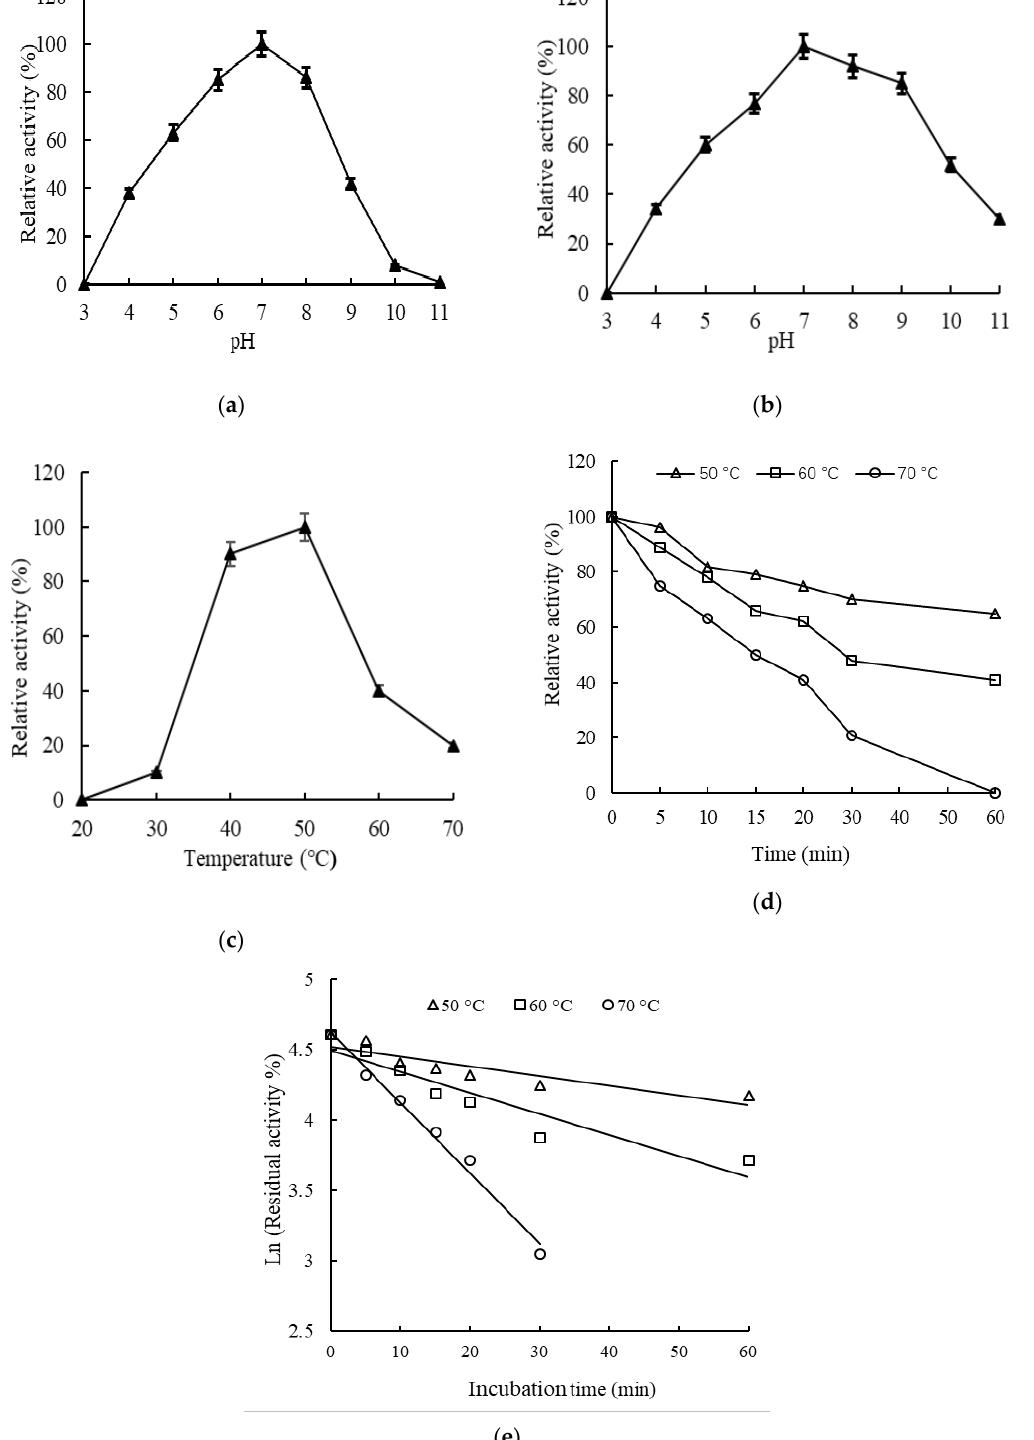
Figure 3. ( a ) Optimal pH of rAga-ms-R. ( b ) pH stability of the rAga-ms-R. T. ( c ) Optimal temperature of recombinant agarases. ( d ) Temperature stability of the rAga-ms-R. ( e ) Thermal inactivation of rAga-ms-R. The values represent mean ± standard error of three independent